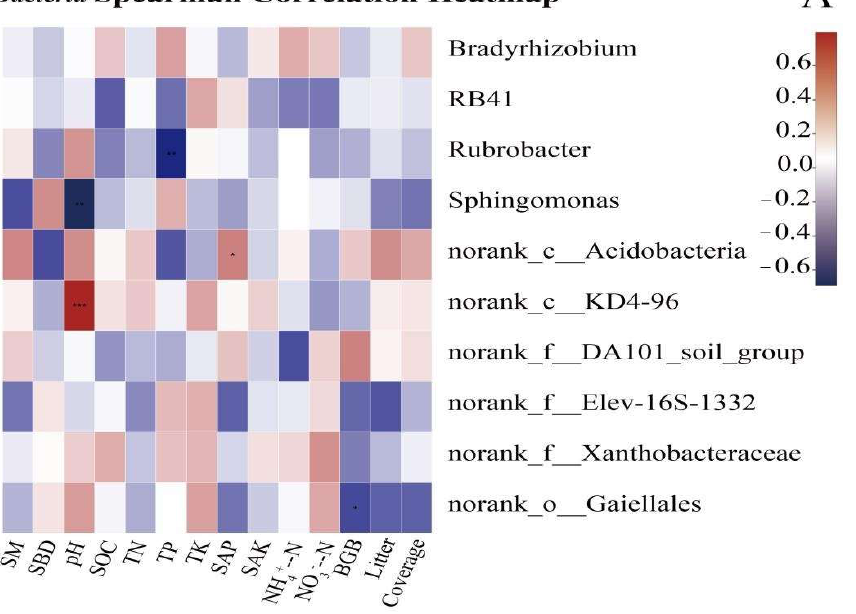
Figure 6. Heatmap analyses of the correlations between bacterial and fungal species abundance and environmental factors. ( A ) is the Heatmap of bacteria; ( B ) is the Heatmap of fungal. The Spearman correlation coefficient was calculated between the environmental factors and the abundance of the top 10 species to obtain the numerical matrix that is visually displayed in the heatmap. The X-axis and the Y-axis are the environmental factors and species, respectively. Color changes reflect the data in the two-dimensional matrix or table. The color depth represents the data values. The legend on the right is the color interval of different R